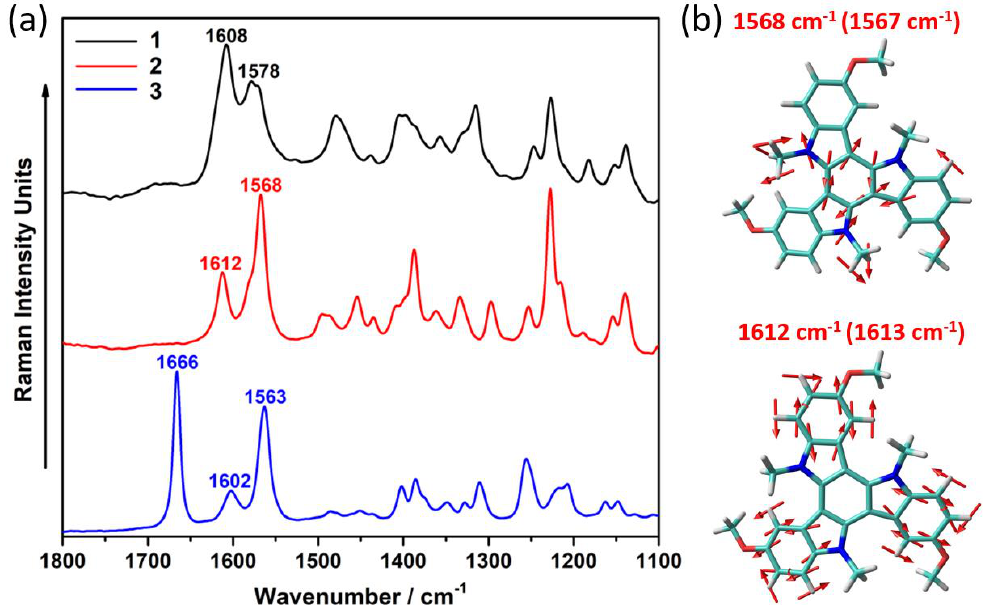
Figure 4. ( a ) Solid-state FT-Raman ( λ exc = 1064 nm) spectra for 1 – 3 compounds; ( b ) B3LYP/6-31G** vibrational eigenvectors associated with the most outstanding C=C/C−C Raman features of 2 , taken as representative example. The experimental and theoretical (in parentheses) wavenumbers are also shown.